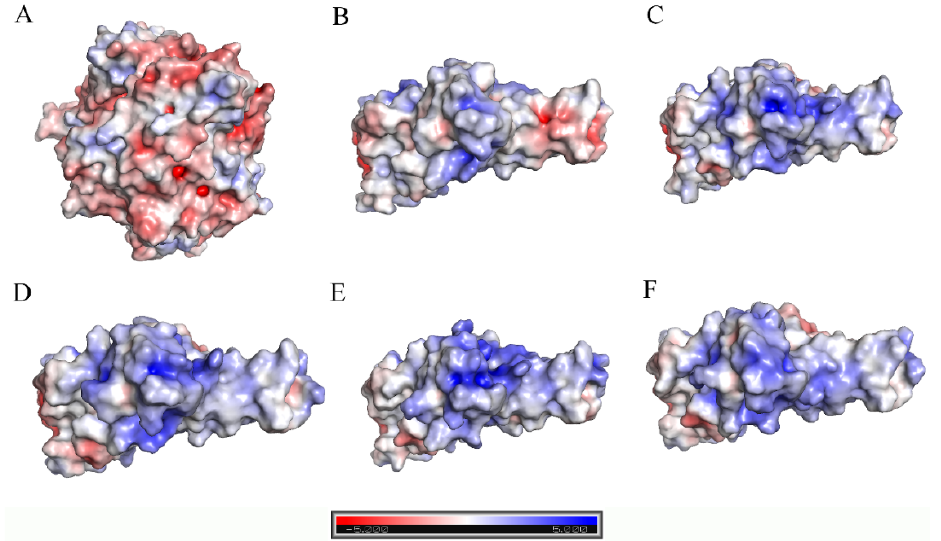
Figure 7. The electrostatic surface potentials (ESPs) of the binding surface of ACE2 and RBDs. ( A ) ACE2. ( B ) RBD WT . ( C ) RBD BA.1 . ( D ) RBD BA.2 . ( E ) RBD BA.3 . ( F ) RBD BA.4/5 . The red and blue colors denote the negative and positive potentials, respectively.